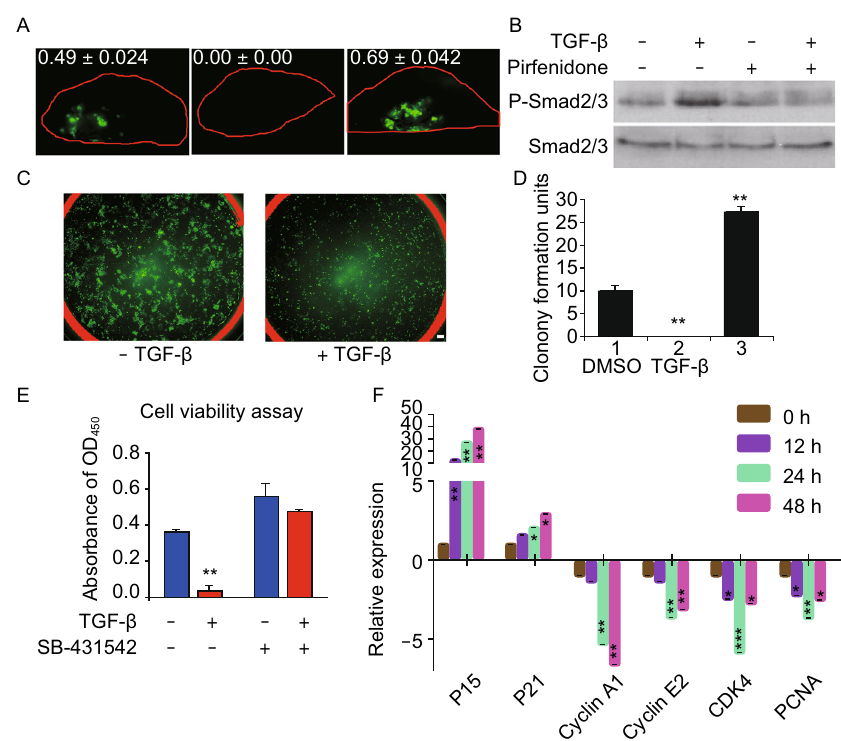
Figure 6. TGF- β signaling modulates SOX9 + BC proliferation. (A) Direct fl uorescence image of mouse lung transplanted with 1 × 10 6 GFP-labeled SOX9 + BCs under dissection microscope. Each lung was from mouse with indicated treatment and harvested 7 days after transplantation. The left lobes were analyzed and the GFP + cell numbers (×10 6 ) were counted by fl ow cytometry analysis. Biological replicates, n = 3. PFD, Pirfenidone. (B) SOX9 + BCs were stimulated with 10 ng/mL TGF- β for 2 h, with or without 1 mg/mL Pirfenidone treatment overnight. Western blotting of cell lysates with anti-phosphated-Smad2/3 and anti-total Smad2/3 antibodies was performed to examine the activation of TGF- β pathway. (C) Direct fl uorescence imaging of GFP-labeled SOX9 + BCs cultured in a 6-well plate in the absence or presence of 10 ng/mL TGF- β . Scale bar, 200 μ m. (D) Quanti fi cation of clonogenicity of SOX9 + BCs in the presence of 10 ng/mL TGF- β or 10 mmol SB. SB, TGF- β type I receptor inhibitor SB-431542. Technical replicates n = 3. (E) WST viability assay of SOX9 + BCs treated by 10 ng/mL TGF- β or 5 mmol TGF- β inhibitor SB-431542, or their combination. Technical replicates n = 3. (F) qPCR showing cell cycle-related gene expression level of SOX9 + BCs with 10 ng/mL TGF- β treatment for indicated h. Biological replicates, n